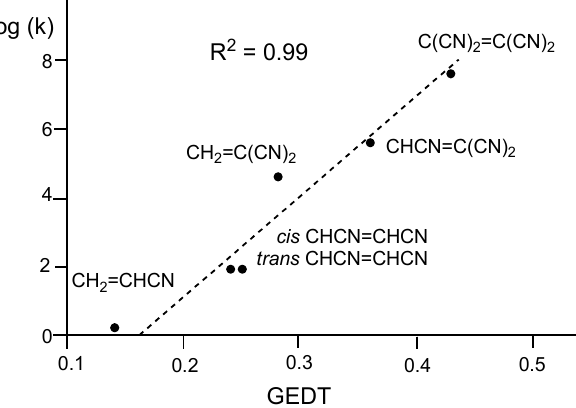
Figure 3. Plot of the logarithm of the experimental rate constant k vs GEDT, in e, for the DA reactions of Cp 6 with the cyanoethylene series 7 ; R 2 = 0.99 [72]. Calculations were performed at the B3LYP/6-31G(d) level.